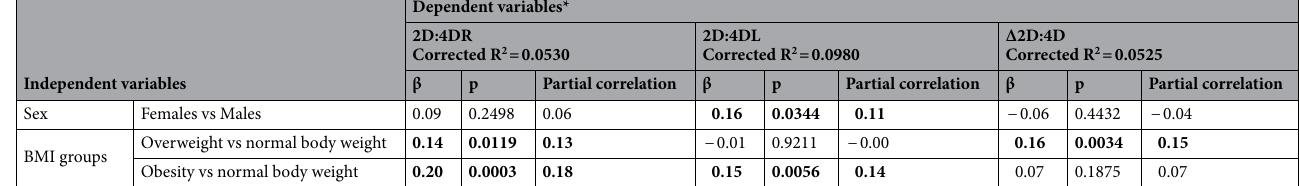
Table 2. Multiple regression analysis results concerning the relationship of 2D:4D ratios and Δ2D:4D with sex and BMI groups. *Adjusted to age after Box-Cox transformation and body height. 2D:4D, second to fourth digit ratio; R, right hand; L, left hand; Δ2D:4D = 2D:4DR -2D:4DL; β, standardized regression coefficient; p, probability; Corrected R 2 , effect size; statistically significant relationships are marked in bold.